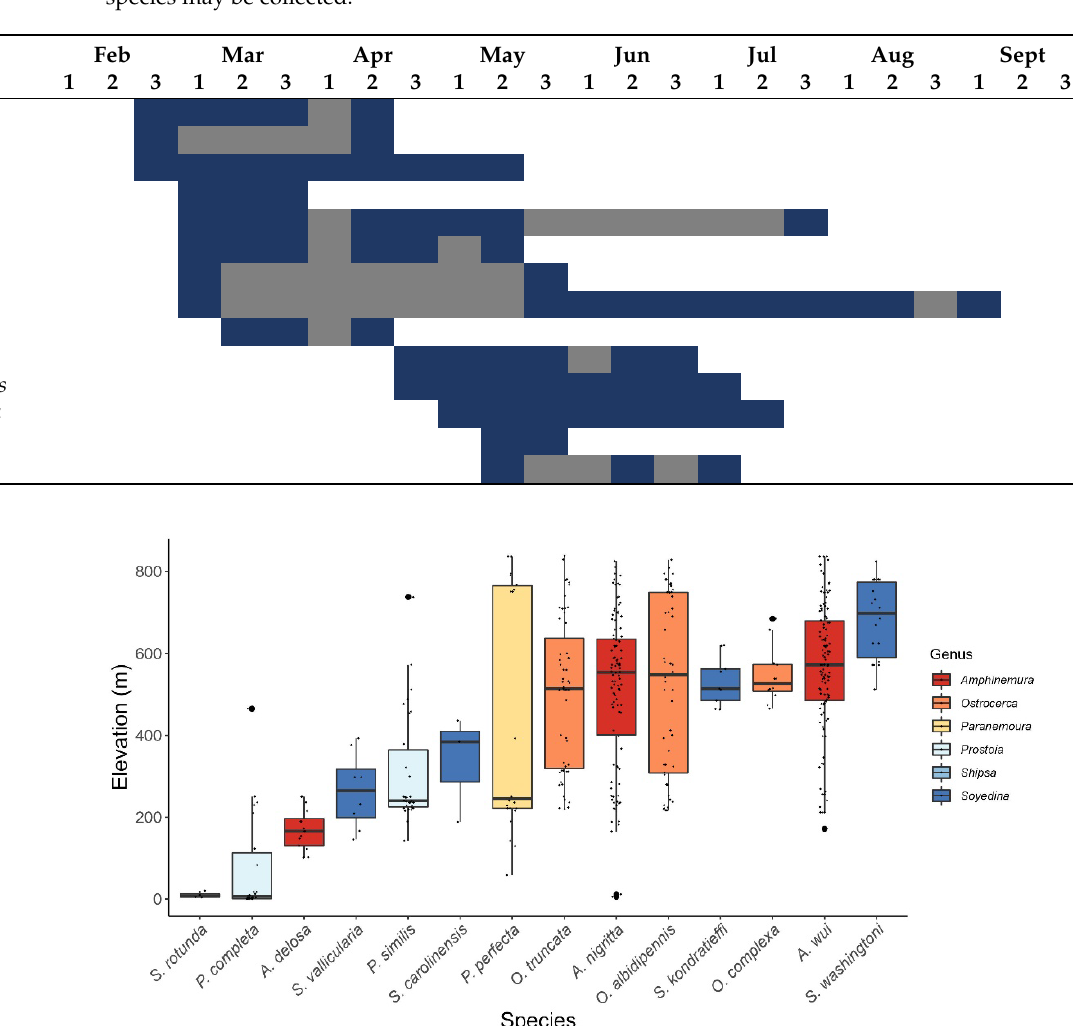
species may be collected.